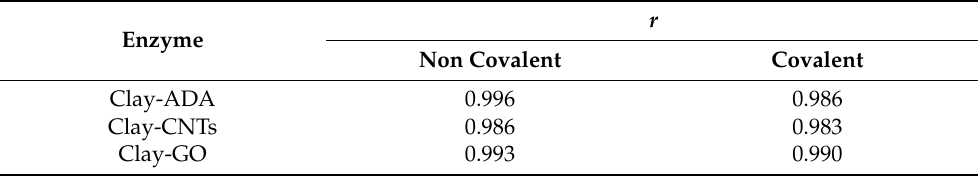
Table 2. Correlation coefficient ( r ) of immobilized TvL on hybrid